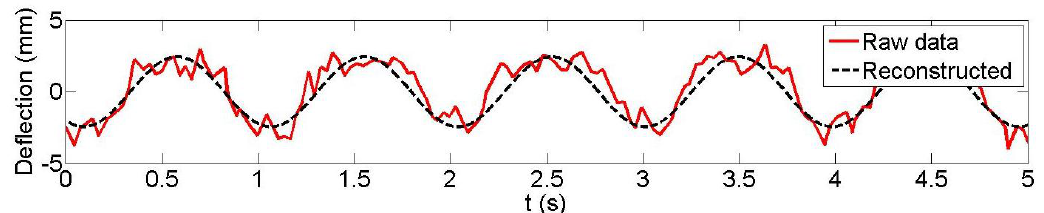
Figure 7. Kinect observed and reconstructed vertical displacements ( = 1 Hz), dataset 4 witness plate